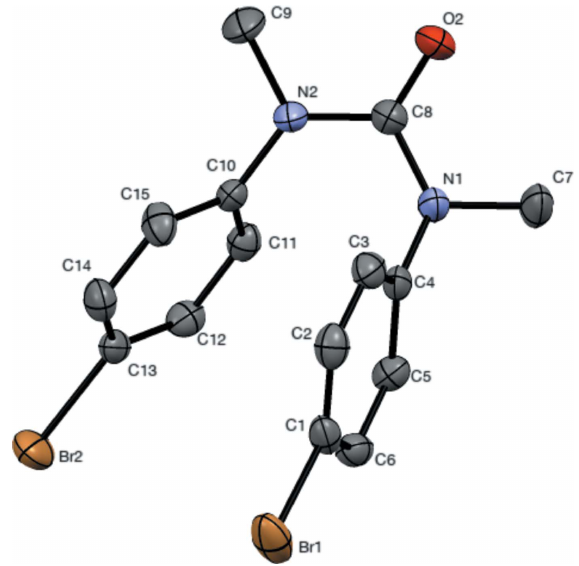
Figure 1 The molecular structure of the title compound showing the atom numbering with displacement ellipsoids drawn at the 50% probability